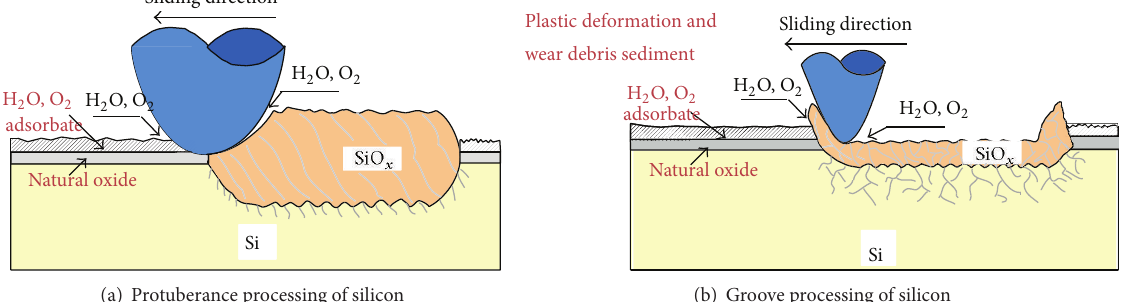
Figure 4: Mechanistic models for (a) protuberance and (b) groove processing by diamond tip sliding.